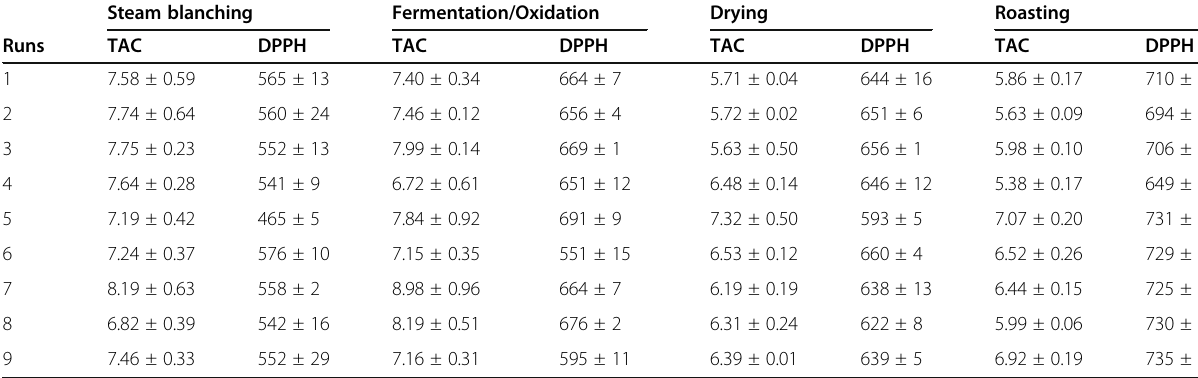
Table 3 Antioxidant properties of steam-blanched, fermented/oxidised, dried and roasted Moringa leaf extracts Steam blanching Fermentation/Oxidation Drying Roasting